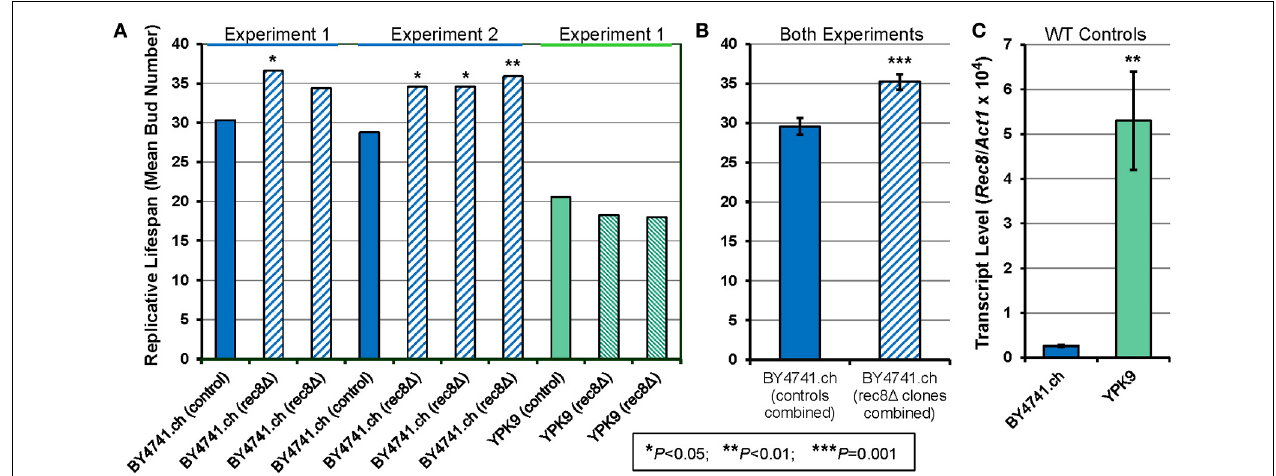
FIGURE 4 | Deletion of REC8 increases replicative lifespan in a long-lived yeast strain that limits transcripts of this gene. (A) Replicative lifespan was measured for the BY4741.ch strain and 5 independent deletion mutations, all assessed as haploids, in two experiments. In the first experiment, strain YPK9 and two REC8 deletion mutants were also assessed. Means lifespans (in generations) are shown, with the significance of differences from the parental control strain indicated by asterisks. Four of the five BY4741 deletion clones were significantly longer lived than the within-experiment control, by P < 0 . 05; the combined significance of the 5